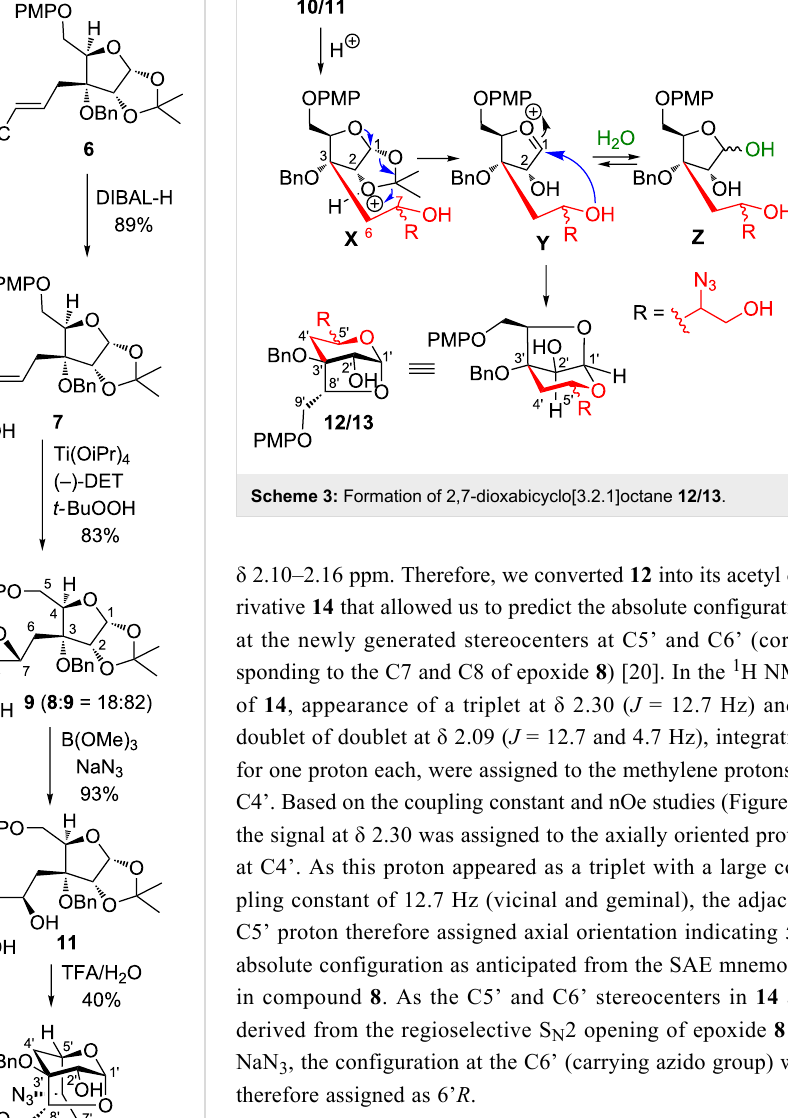
Figure 2. The adoption of the twist-boat conformation